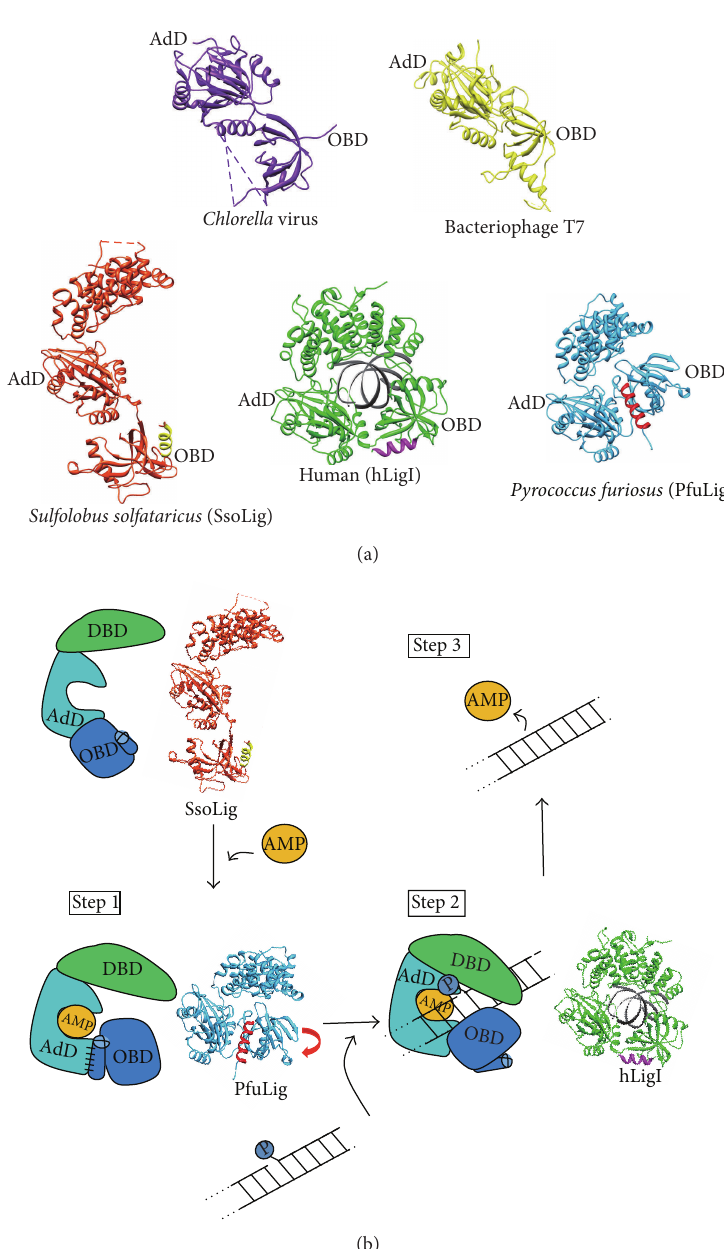
Figure9:CrystalstructuresofATP-dependentDNAligases.(a)TheviralandbacterialATP-dependentDNAligasesfrom Chlorella virus(left, blue) and bacteriophage T7 (right, yellow) are two-domain ligases. These ligases revealed the common structures of two distinct domains, designated as the adenylylation domain (AdD) and the oligonucleotide/oligosaccharide-binding-fold domain (OBD), which are jointly called the catalytic core domains. In these two structures, the catalytic core domains adopted an open form. The three-domain structure of DNA ligaseischaracteristicofthearchaeal( Sulfolobus solfataricus :SsoLig(orange,left)and Pyrococcus furiosus :PfuLig(blue,right))andeukaryotic (human: hLigI (green, center)) DNA ligases. The AdD contains most of the catalytic residues and is assisted by two flanking domains that also bind to DNA, the N-terminal DNA-binding domain (DBD) and the C-terminal OBD. Each C-terminal helix is highlighted in yellow (SsoLig), magenta (hLigI), and red (PfuLig). The figure was prepared using Chimera [105]. (b) Schematic diagram of the structure-based ligation mechanism. Before and after the ligation reaction, DNA ligase adopts the extended conformation, as expected from the SsoLig crystal structure. In step 1, the closed conformation of the catalytic core domains at the carboxyl terminus in PfuLig creates a small compartment, which holds a covalently bound AMP molecule. In step 2, the interactions with the substrate DNA must be stabilized for the enzyme to adopt a compact conformation, as seen in the crystal structure of hLig1 bound to the nicked-DNA. Finally, the ligation of the DNA strands and the subsequent release of AMP and DNA strands from DNA ligase occur during step